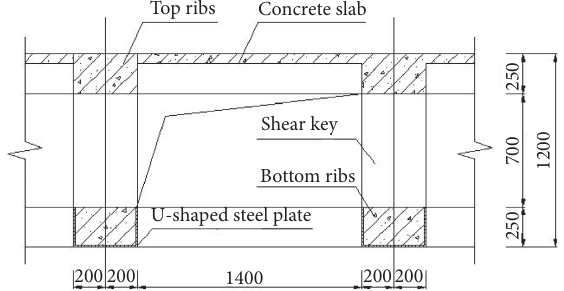
Figure 4: Profile of the composite floor.